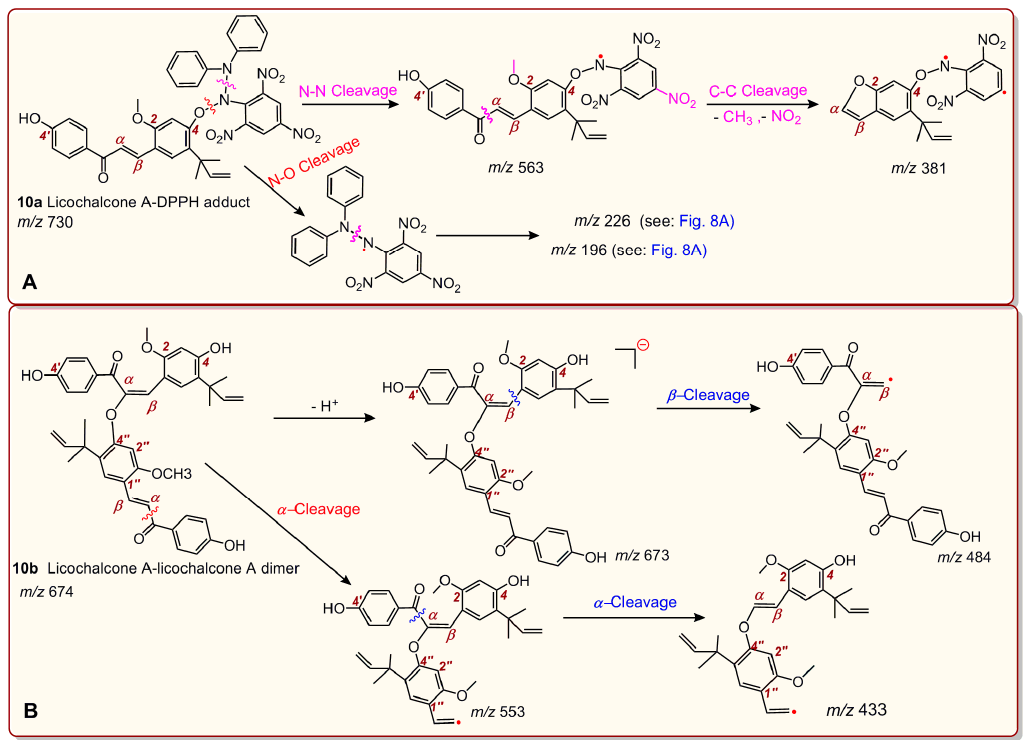
Figure 11. Full MS elucidation of the licochalcone A–DPPH adduct ( A ) and the licochalcone A–licochalcone A dimer ( B ). The MS spectra were obtained in the negative ion mode, and the charge imposed by the MS field was not marked. Other reasonable cleavages should not be excluded in the MS elucidation.